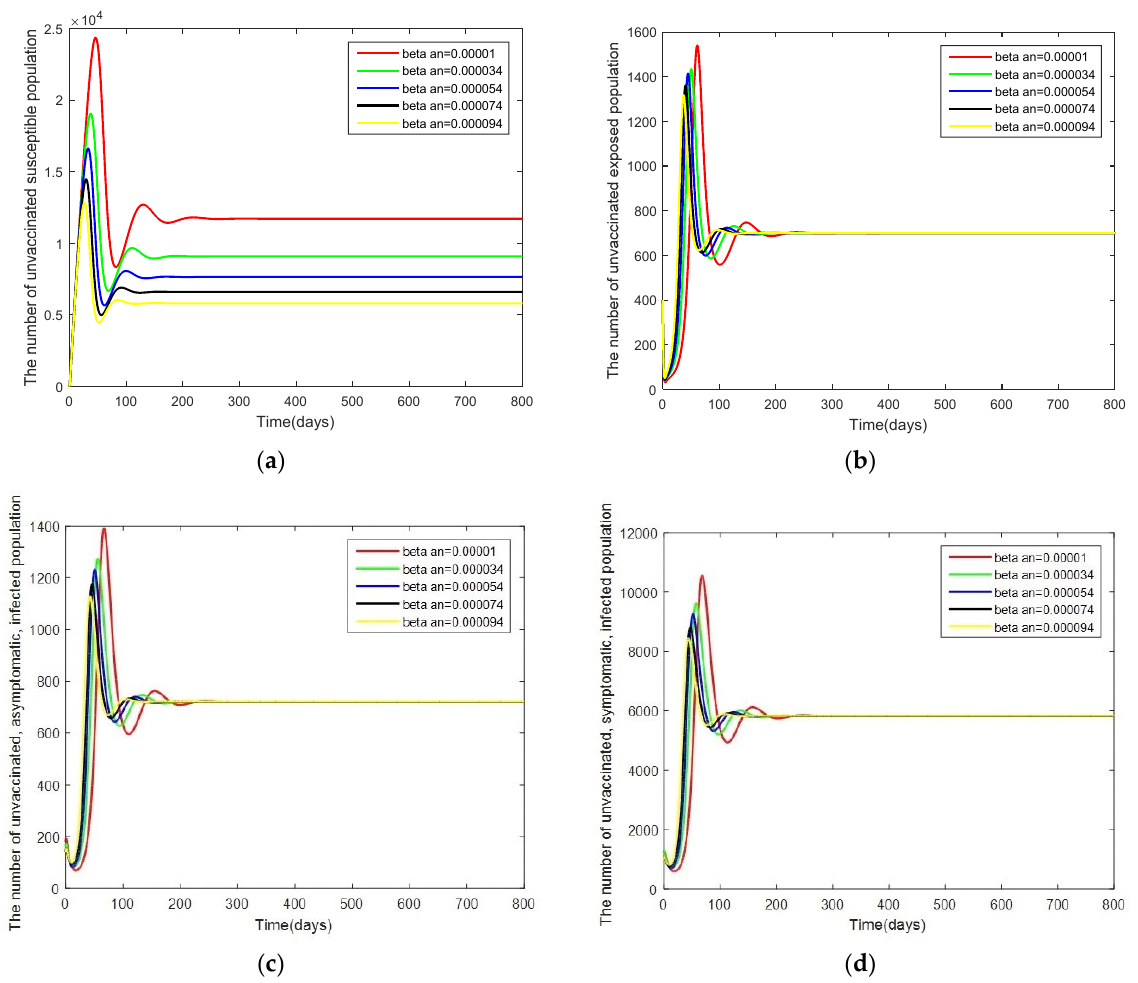
Figure 6. Graphs of the system of Equations (3)–(12) showing the comparison results of the infection rate of the asymptomatic, unvaccinated, infected population ( β an ) when R 0 > 1: ( a ) the number in the unvaccinated, susceptible population; ( b ) the number in the unvaccinated, exposed population; ( c ) the number in the unvaccinated, asymptomatic, infected population; and ( d ) the number in the unvaccinated, symptomatic, infected population.